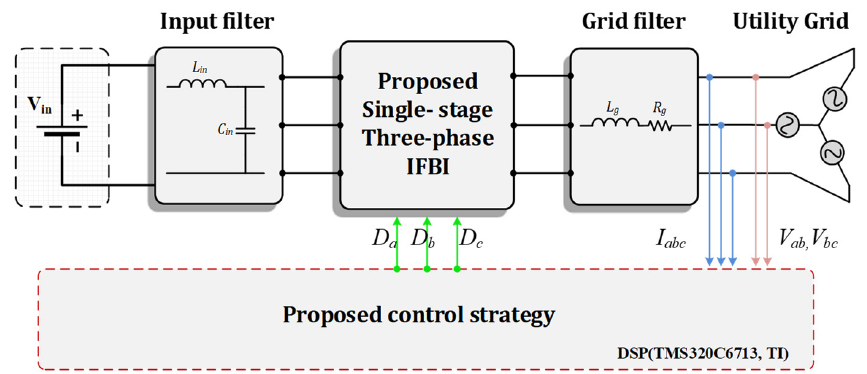
Figure 6. Proposed IFBI control scheme.